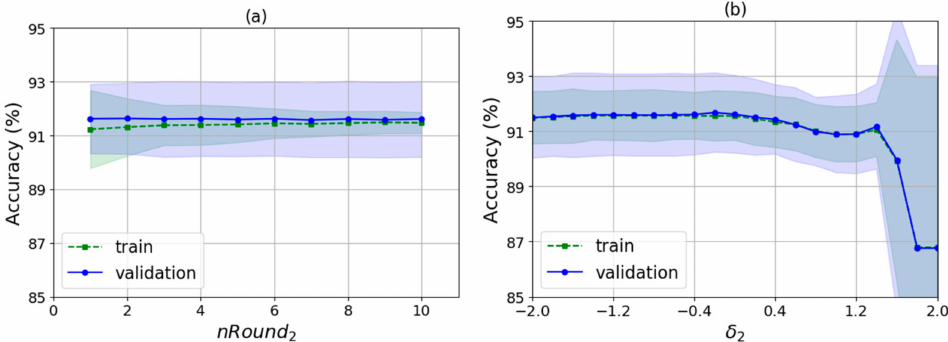
Figure 7. Accuracy of FCE-KNN for identifying application types of encrypted flows with di ff erent values of k 2 : ( a ) k 2 from 1 to 101, interval 10; ( b ) k 2 from 1 to 20, interval 1.